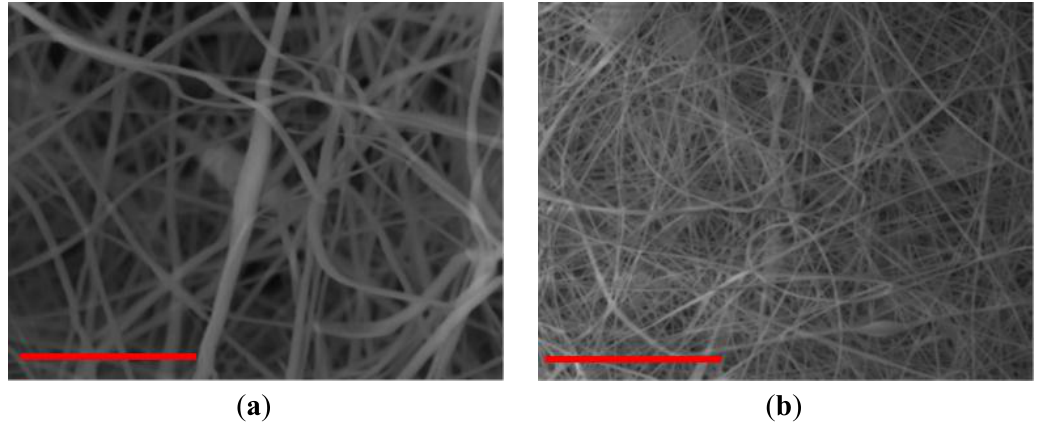
Figure 2. SEM images of PVC fiber with 4 wt % PVP fibers at spinneret distance of ( a ) 20 cm and ( b ) 30 cm (scale bar is 10 µm).